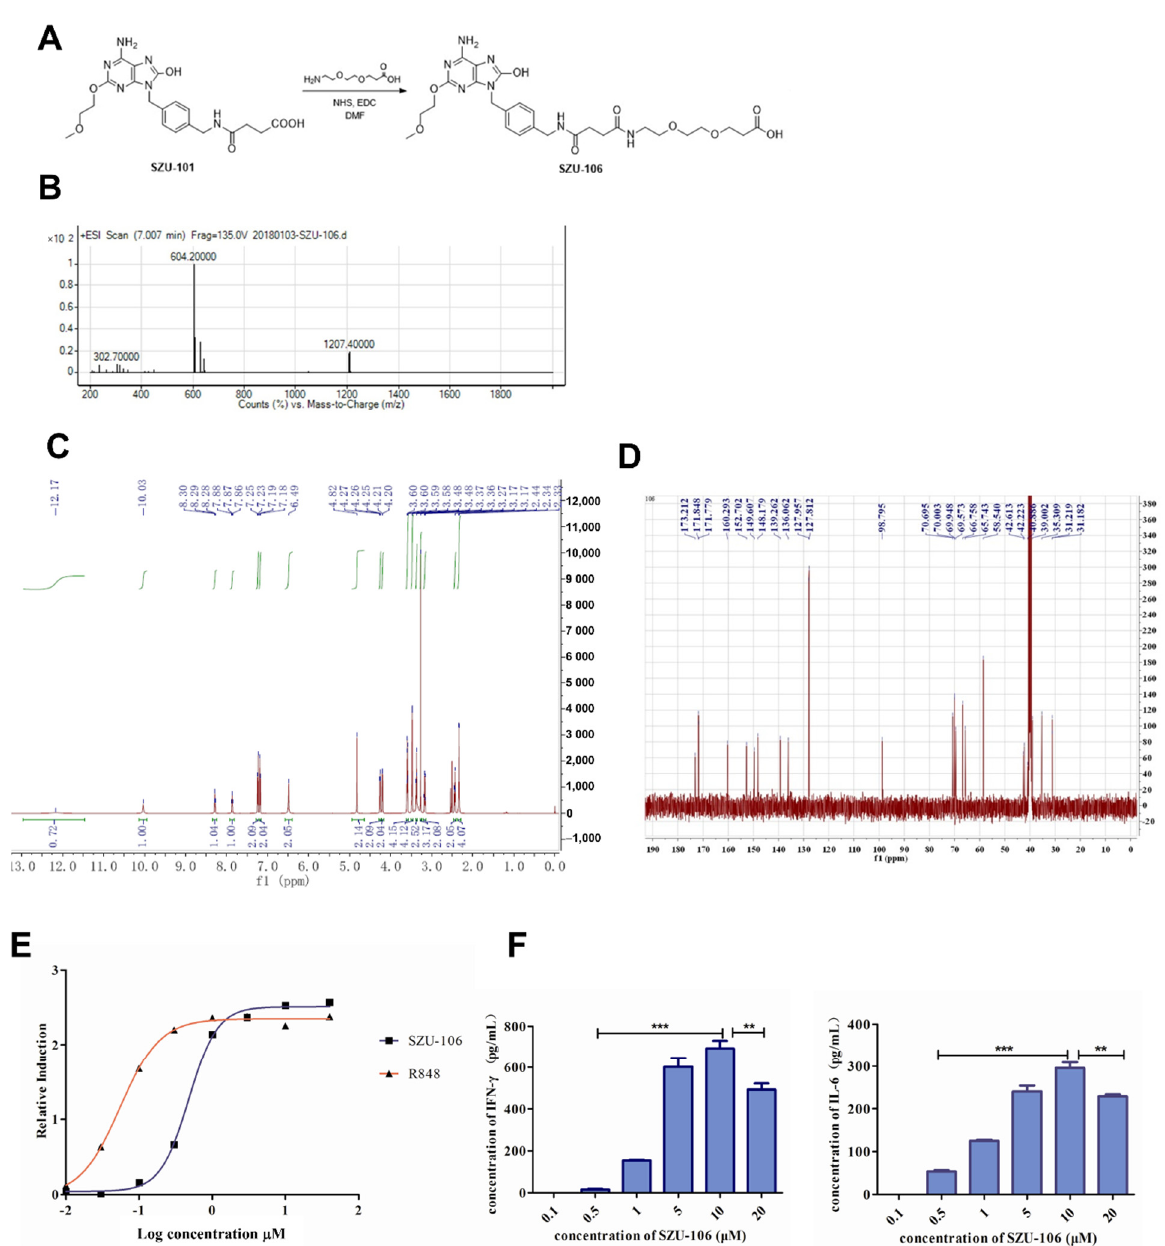
Figure 1. Synthesis of SZU-106 and the activation of TLR7 by SZU-106. ( A ). The synthesis of SZU- 106 from SZU-101 is shown. ( B – D ). Structure confirmation for SZU-106 was performed with mass spectroscopy, 1H NMR, and 13C NMR. ( E ). SZU-106 selectively activated TLR7 and increased the expression of SEAP. ( F ). Cytokine induction in mouse splenic lymphocytes by the TLR7 agonist SZU- 106 was evaluated. Data are expressed as the mean ± SD ( n = 6) of one representative experiment. ** p < 0.01; *** p < 0.001.